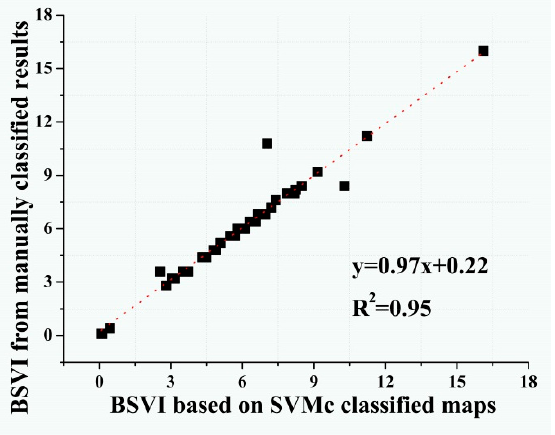
Figure 7. Linear fitting of Baidu Green View Index (BGVI) calculated using SVM versus the refined results.